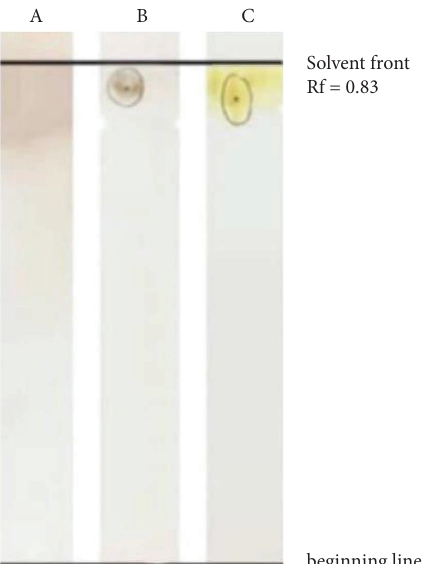
Figure 15: TLC analysis of partially purifed biosurfactant extracted from P. guguanensis strain Iraqi ZG.K.M. Te chromatograms were (A) sprayed with 1% ninhydrin solution, (B) sprayed with Molish’s reagent, and (C) exposed to iodine